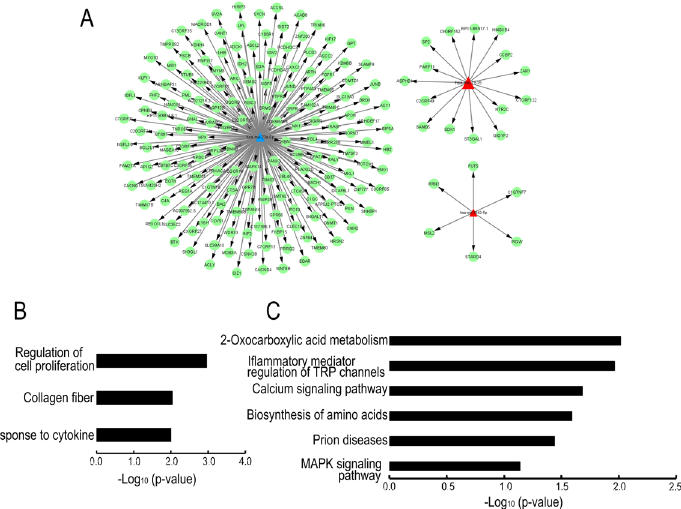
Figure 4. Exosomal miRNA bioinformatic analysis under Col-1 stimulation. ( A ) MiRNA-predicted target gene network. Triangular nodes represent upregulated miRNAs in red and downregulated miRNAs in blue. Green circles represent target genes. ( B and C ) Histograms of upregulated signaling pathways according to the results of GO ( B ) and KEGG pathway analyses ( C ). The X-axis represents the logarithm of the p-value, and the Y-axis represents the enriched pathway